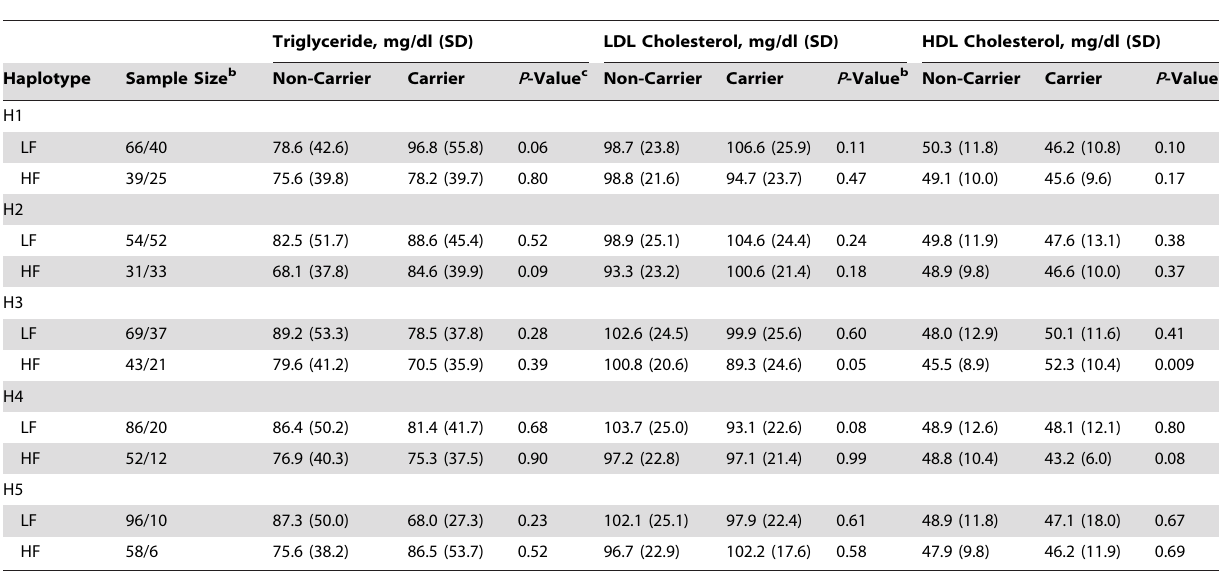
Table 4. Effect of haplotype on triglycerides, LDL-cholesterol and HDL-cholesterol in 108 obese females (cohort # 3) on calorie restricted diet.